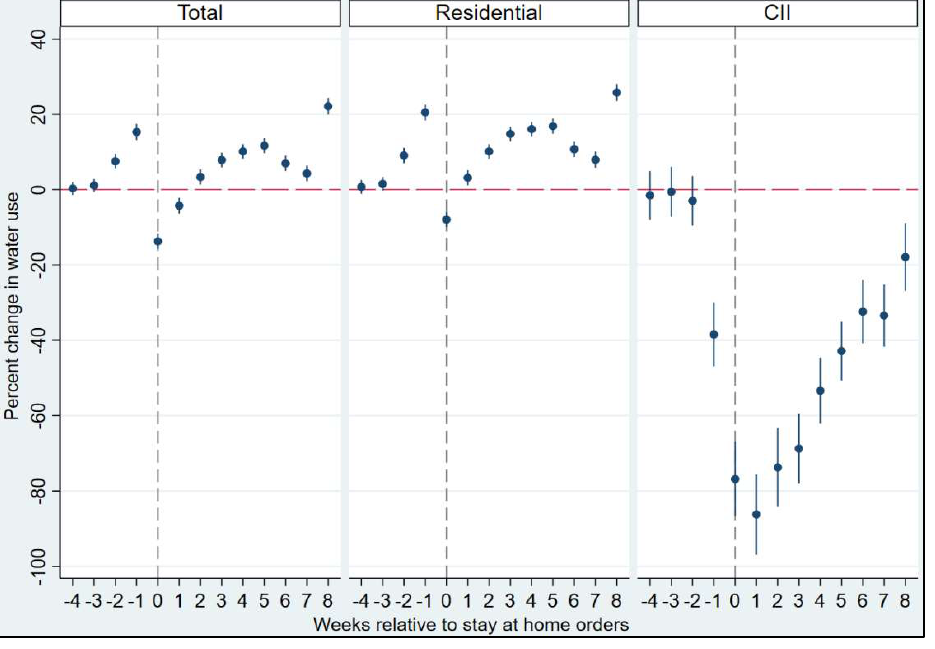
Figure 4. Weekly percent change in water use before and after the stay-at-home orders in Utility C (FL) for total, residential, and CII sectors. Notes: vertical dashed lines indicate the start of stay-at- home orders.